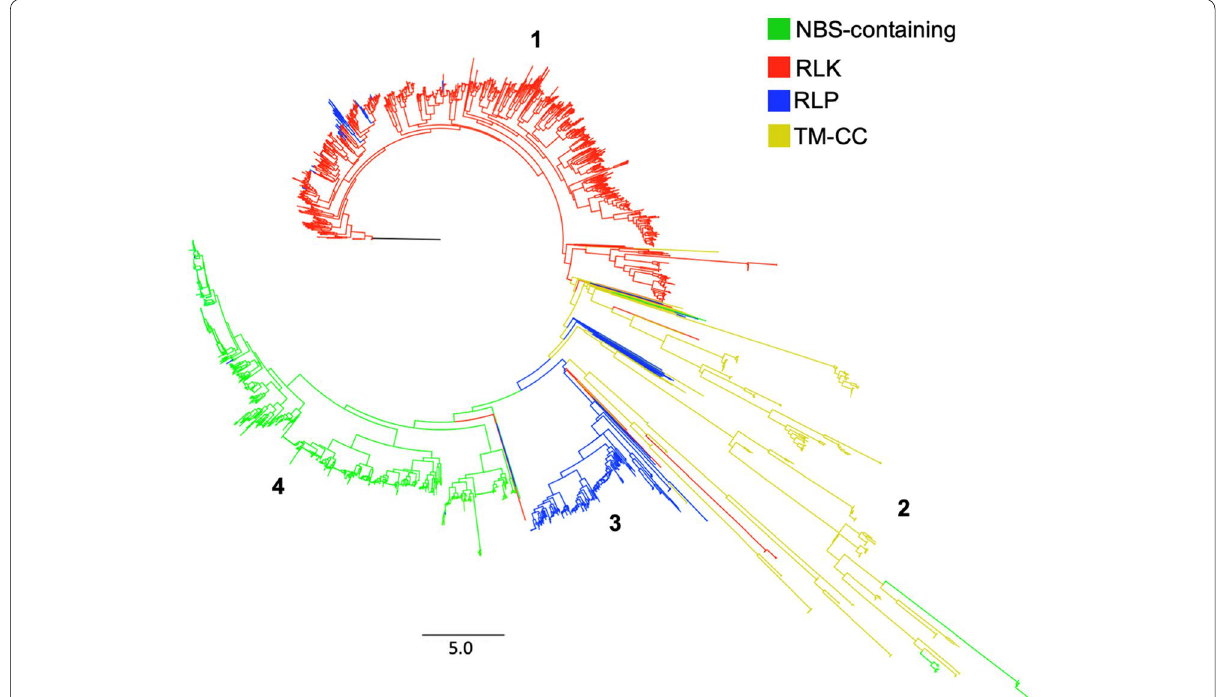
Fig. 3 Maximum likelihood phylogenetic tree constructed from the sequence alignment of genome-wide RGAs of